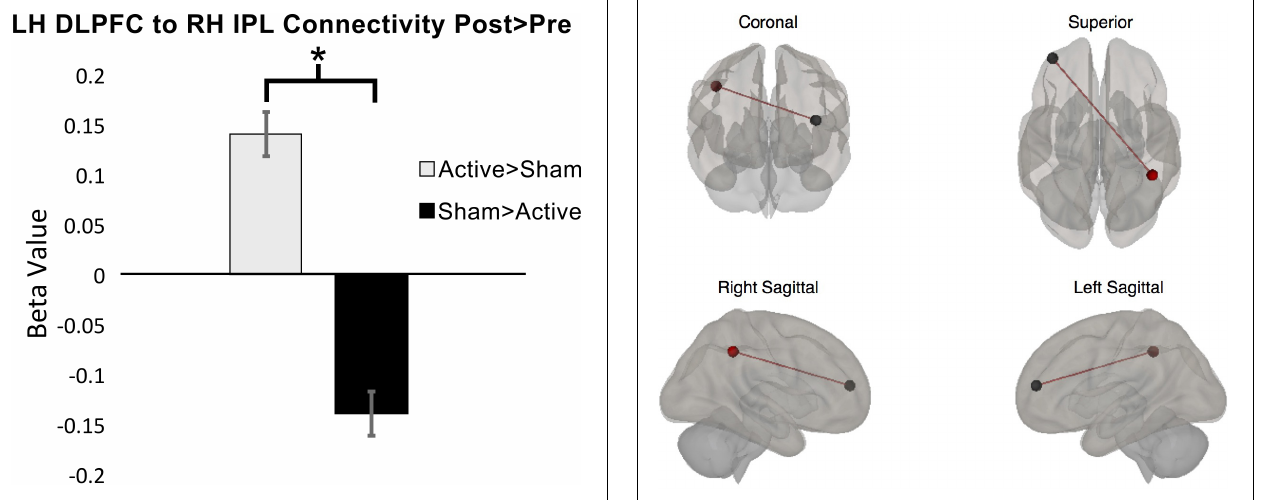
FIGURE 5 | Seed to target ROIs with significantly increased connectivity during the 2-Back task at post-intervention (ROI colors: Red = left DLPFC; Black = right